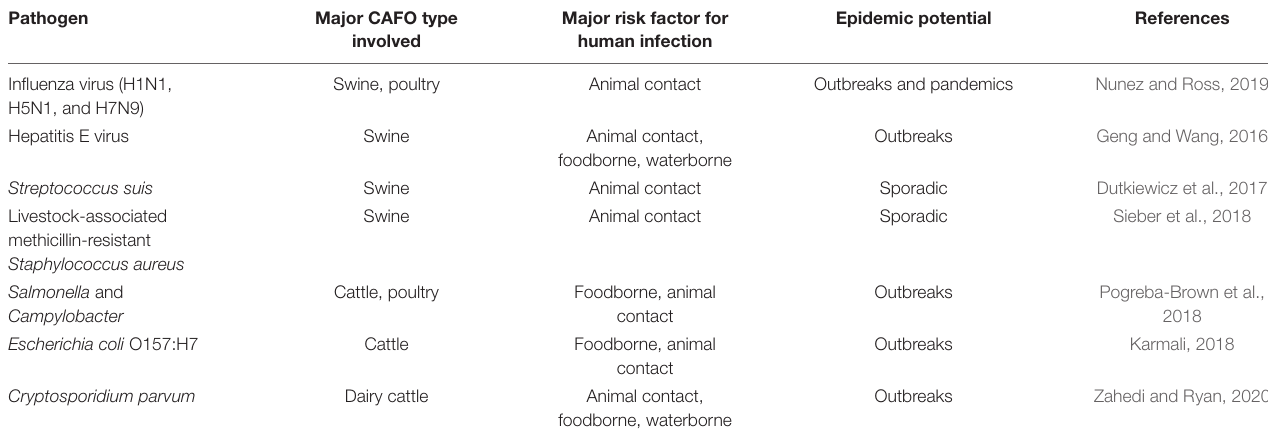
TABLE 1 | Major zoonotic pathogens associated with concentrated animal feeding operations (CAFOs) in industrialized